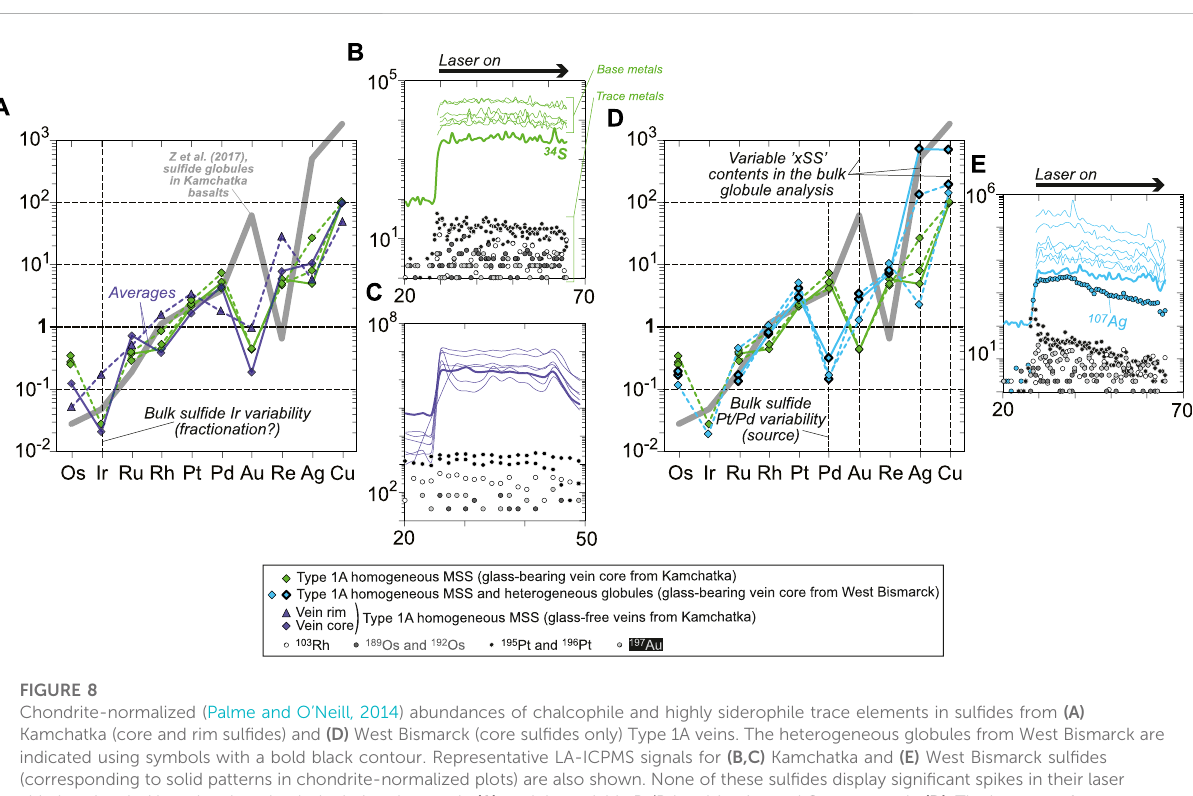
FIGURE 8 Chondrite-normalized (Palme and O ’ Neill, 2014) abundances of chalcophile and highly siderophile trace elements in sul fi des from (A) Kamchatka (core and rim sul fi des) and (D) West Bismarck (core sul fi des only) Type 1A veins. The heterogeneous globules from West Bismarck are indicated using symbols with a bold black contour. Representative LA-ICPMS signals for (B,C) Kamchatka and (E) West Bismarck sul fi des (corresponding to solid patterns in chondrite-normalized plots) are also shown. None of these sul fi des display signi fi cant spikes in their laser ablation signals. Note the changing Ir depletion degrees in (A) , and the variable Pt/Pd and Au, Ag, and Cu contents in (D) . The latter two features can be used to characterize West Bismarck sul fi des, which have systematically high Pt/Pd and can be enriched in Au, Ag, and Cu